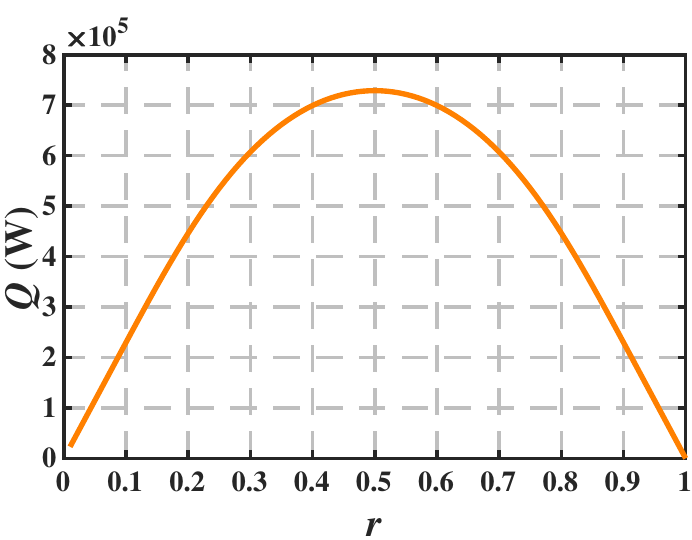
Figure 9. The amount of heat transferred under certain mechanical energy